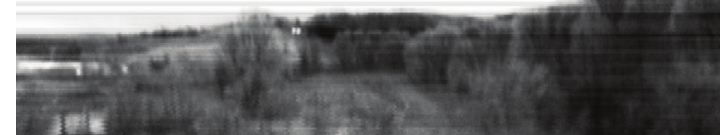
Figure 15: Enhanced image where the means subtraction has been performed excluding the bright